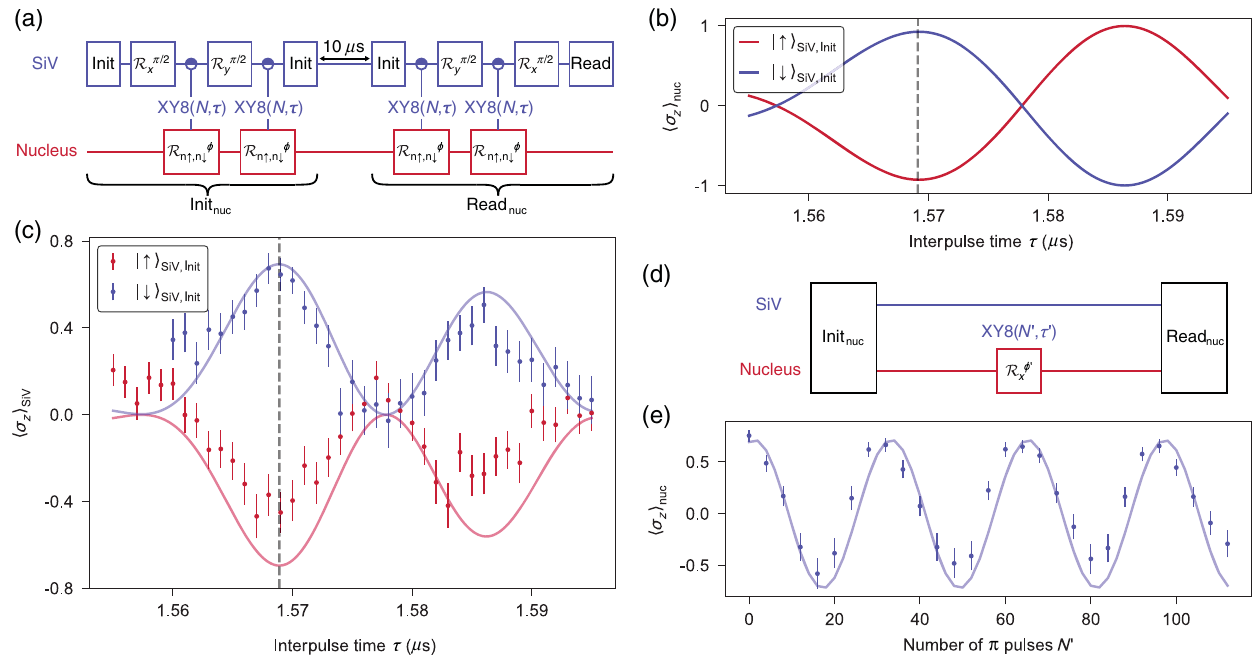
FIG. 3. Mechanical control of a single 13 C nuclear spin. (a) Sequences for mechanically driven nuclear spin initialization (init readout (read ). These are based on entangling conditional rotations of the form R ϕ n ↓ ; n ↑ implemented as acoustic XY8 sequences on nuc the SiV spin. (b) Simulation of the state of the nuclear spin after the nuclear initialization sequence for N ¼ 16 pulses as a function of the interpulse time τ . The red (blue) curve corresponds to a sequence at the beginning of which the SiV spin is in the state j ↑ i ( j ↓ i ). The dashed gray line indicates the value of τ ¼ 1 . 569 μ s later used for nuclear spin initialization. (c) Measurement (dots) and simulation (solid curves) of the final SiV spin projection after the nuclear initialization and readout sequences, as a function of τ , for different initial states of the SiV spin. The measured optimal value of τ ≈ 1 . 569 μ s (dashed gray line) agrees with simulations. The simulation includes the effect of a second nonresonant nuclear spin with weaker hyperfine couplings, which accounts for the reduction in fidelity [34]. (d) Sequence for coherent control of the nuclear spin. After nuclear initialization with τ ¼ 1 . 569 μ s, an XY8 sequence with τ 0 ¼ 1 . 578 μ s rotates the nuclear spin around the X axis of the Bloch sphere with an angle ϕ 0 depending on the number of π pulses ( N 0 ). (e) Mechanically driven Rabi oscillations of the nuclear spin, corresponding to the sequence in diagram (d). The dots represent measured values, while the solid curve corresponds to a simulation using previously determined hyperfine coupling parameters. The error bars in diagrams (c) and (e) represent the standard deviations of the measured